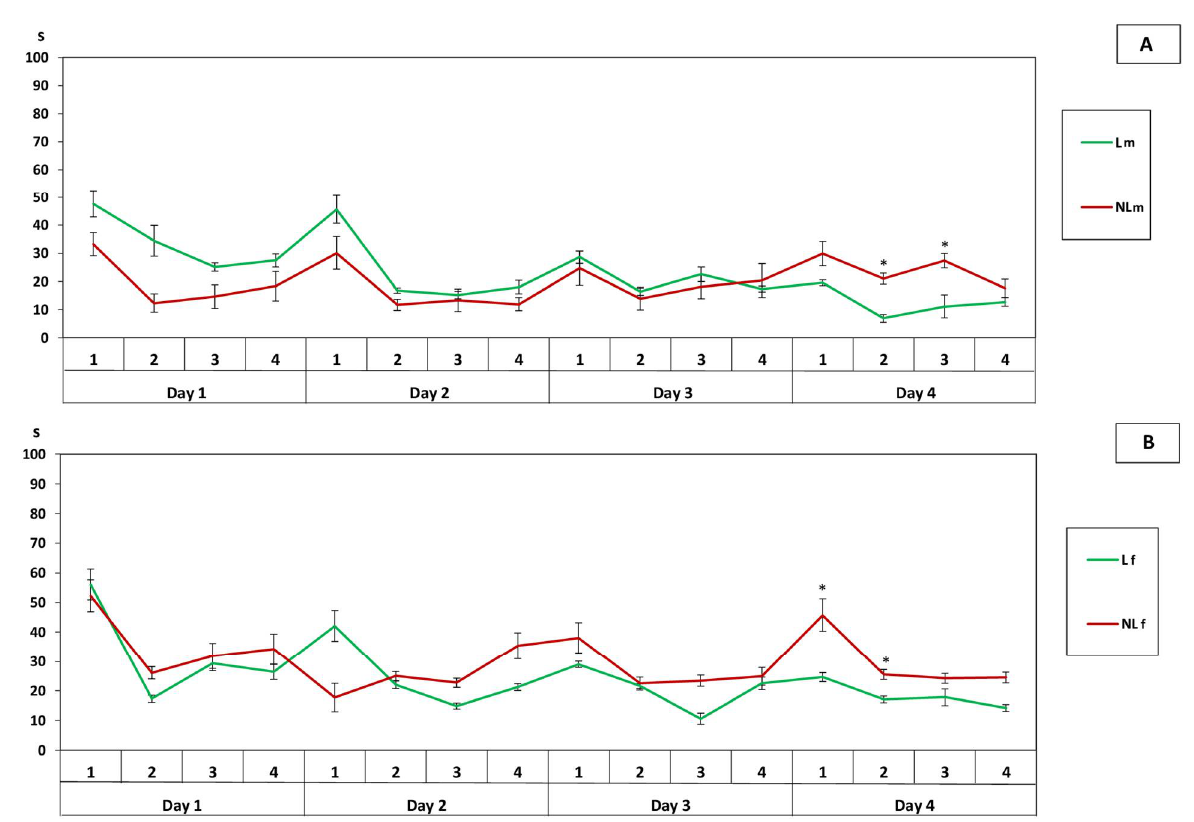
Figure 8. The latency period of reaching the underwater platform (( A )—5-month male rats; ( B )—5-month female rats). * p < 0.05 between L and NL rats.